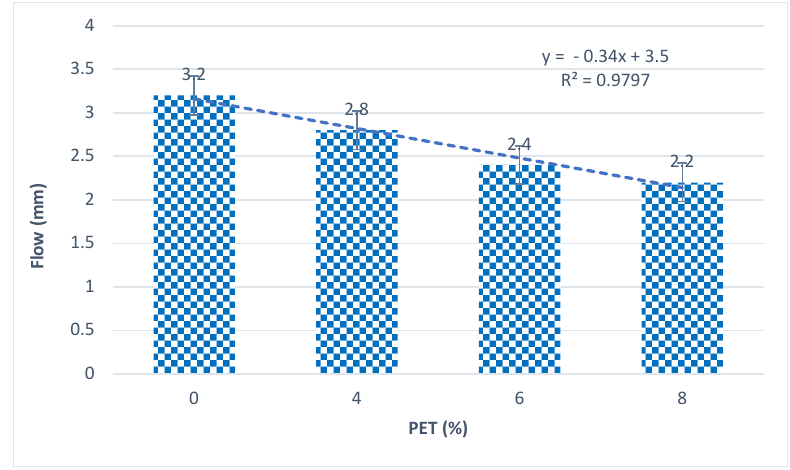
Figure 5. Flow results for the PET-modified AC asphalt mixtures.